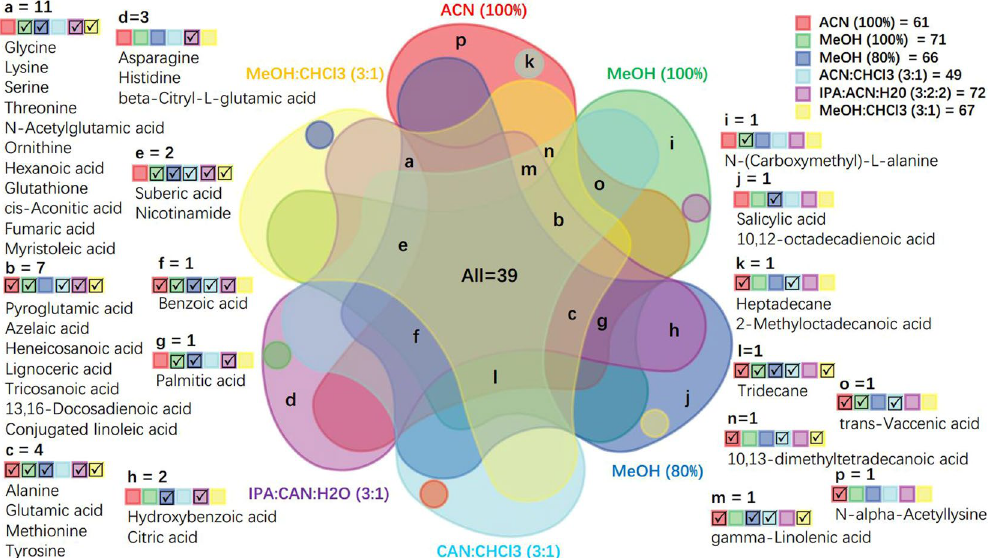
Figure 6. Six-way Venn visualization of the identified metabolite coverage compared across six different extraction methods, in baby panda feces. Red: ACN (100%); green: MeOH (100%); blue: MeOH (80%); cyan: ACN:CHCl 3 (3:1); purple: IPA:ACN:H 2 O (3:2:2); yellow: MeOH:CHCl 3 (3:1). Letter = number of identified metabolites in each color region. √ the existence of extraction methods in the overlapped